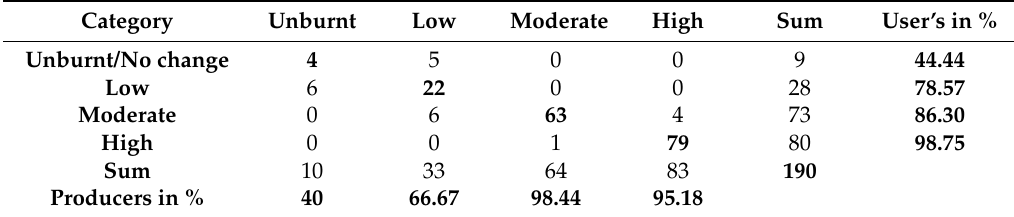
Table 4. Error Matrix of RdNBR derived data 1